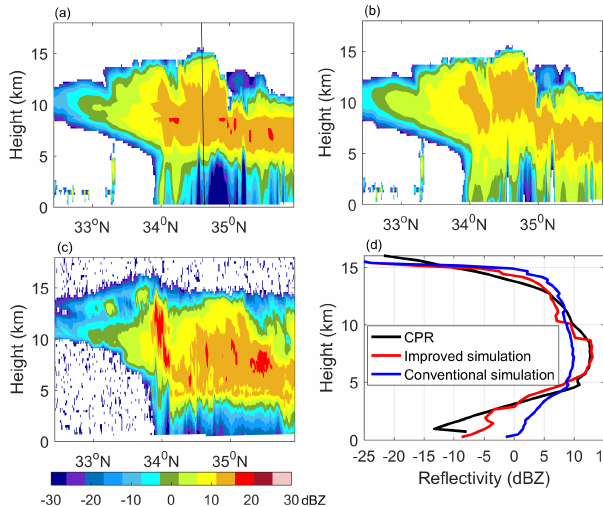
Figure 13. Radar reflectivity comparison between the simulation results and CloudSat CPR observation data for the convective case. (a) Cross section of the simulation result with the improved set- ting, (b) cross section of the simulation result with the conventional setting using a fixed particle density, and (c) cross section of the CloudSat CPR observation data. (d) Vertical profiles of the average reflectivity in (a) – (c) , where the red line represents the simulation result with the improved setting, the blue line represents the simu- lation results with the conventional setting, and the black line rep- resents the result of the CPR observation. The varying prefactor of density relations of snow and graupel due to the effect of riming was considered in the improved simulation. The echo structure and in- tensity between the improved simulation and CloudSat observation showed good agreement.